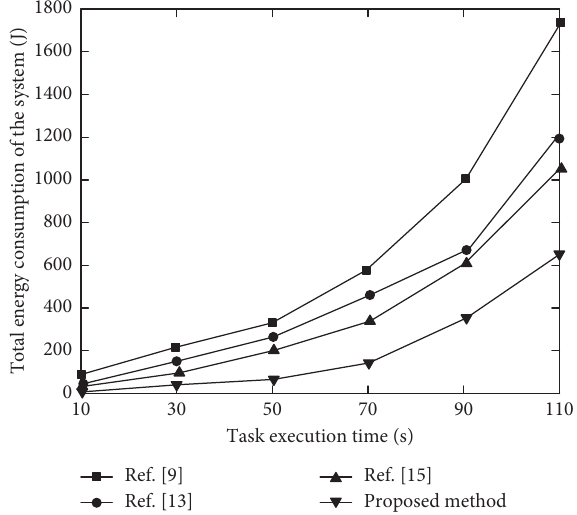
Figure 5: Total energy consumption of the system under different